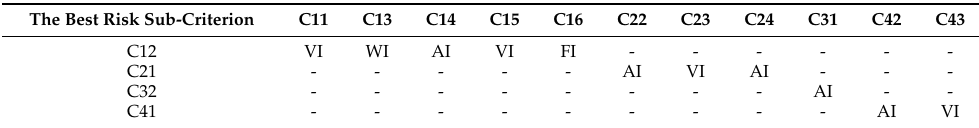
Table 5 lists the linguistic terms for fuzzy preferences of the best risk sub-criterion over other risk sub-criteria, and Table 6 lists the linguistic terms for fuzzy preferences of other risk sub-criteria over the worst risk sub-criterion. Table 5. The linguistic terms for fuzzy preferences of the best risk sub-criterion over other risk sub-criteria.